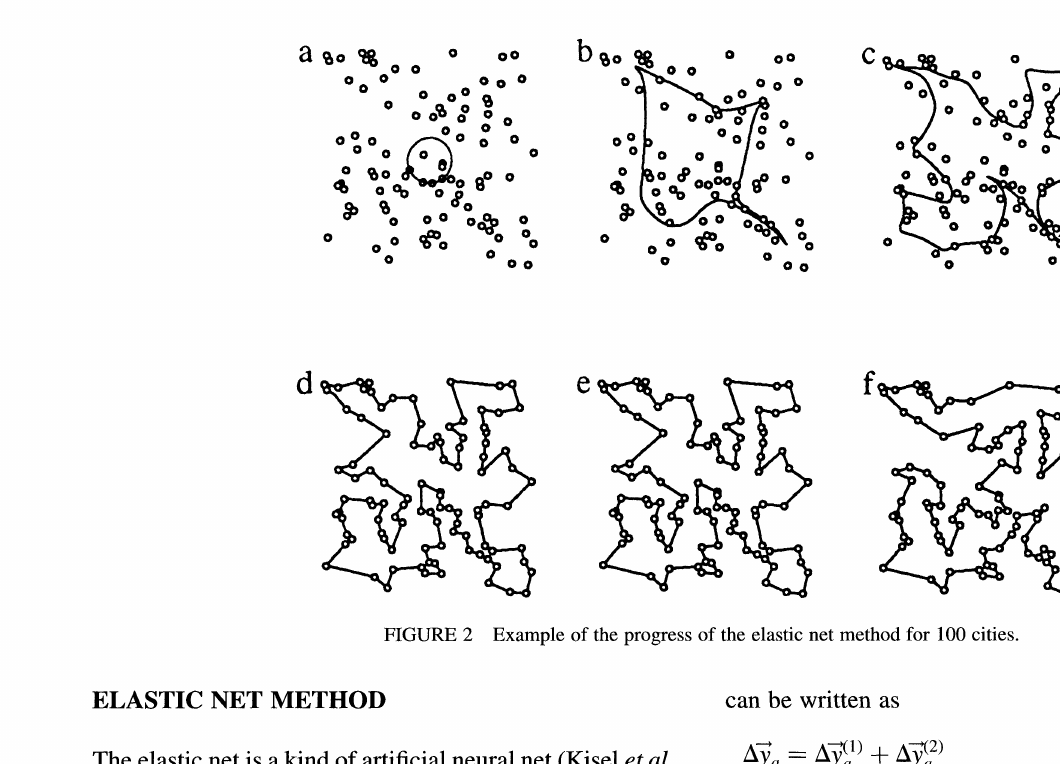
FIGURE 2 Example of the progress of the elastic net method for 100